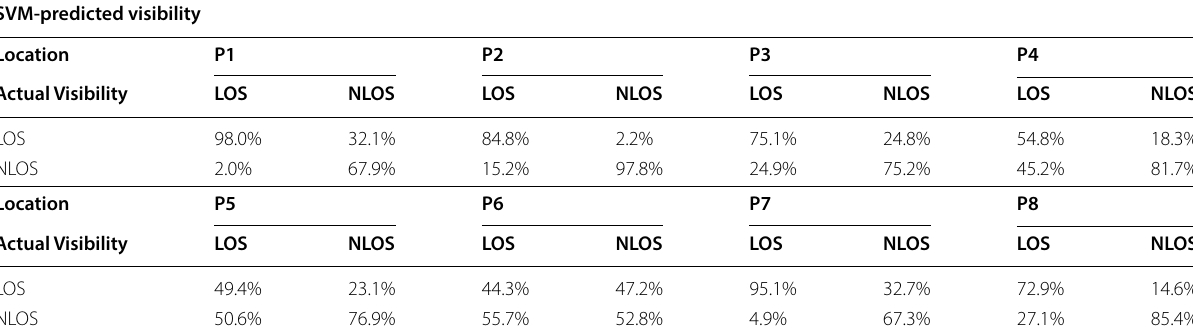
Table 3 Confusion statistic matrix of the experiment using U-BLOX receiver at the Hong Kong urban area SVM-predicted visibility